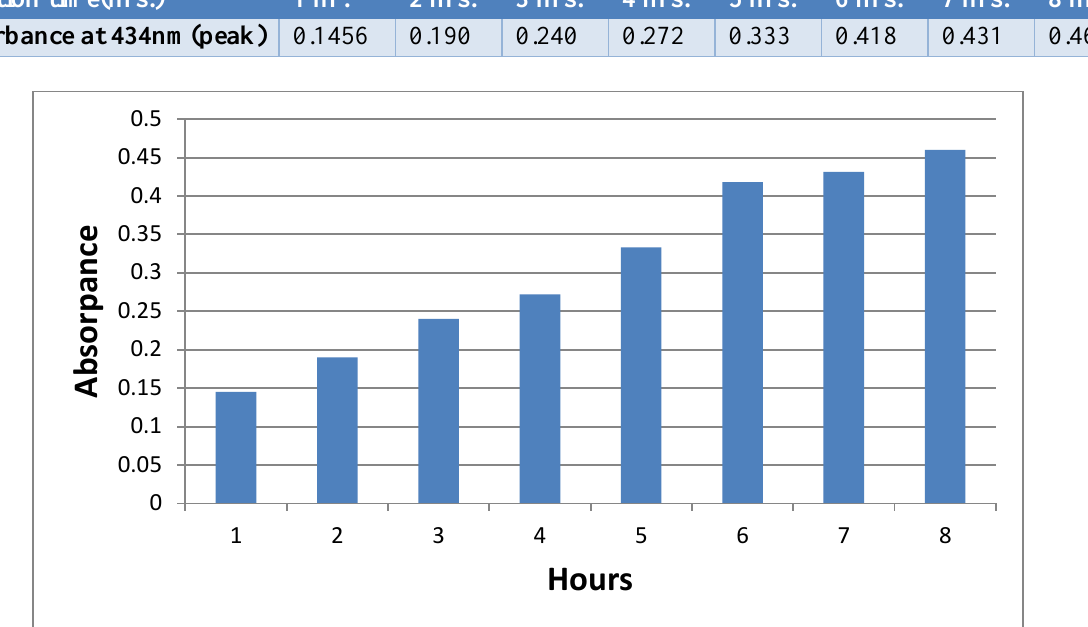
Table, 1: Absorbance values obtained by a spectrophotometer at wavelength 434nm in different Duration time(hrs.)